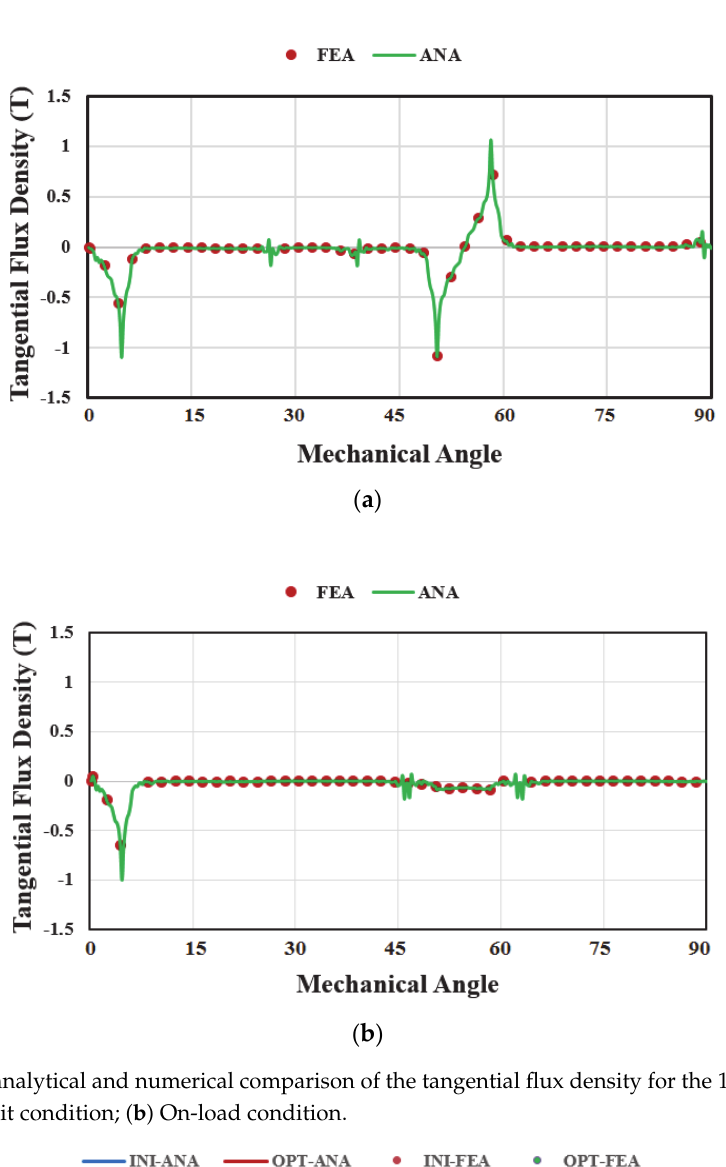
Figure 9. An analytical and numerical comparison of the tangential flux density for the 12S ‐ 10P motor. ( a ) Open circuit condition; ( b ) On ‐ load condition.